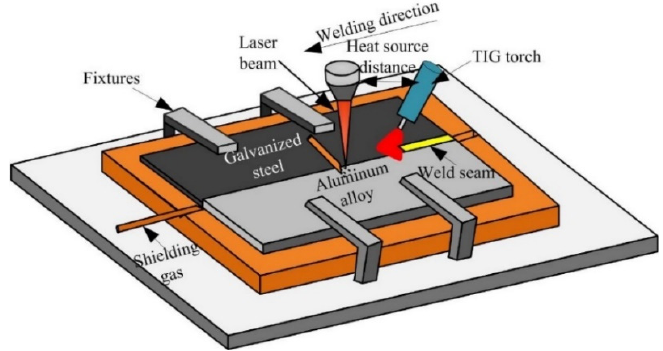
Figure 1. The schematic diagram of arc assisted laser welding-brazing.